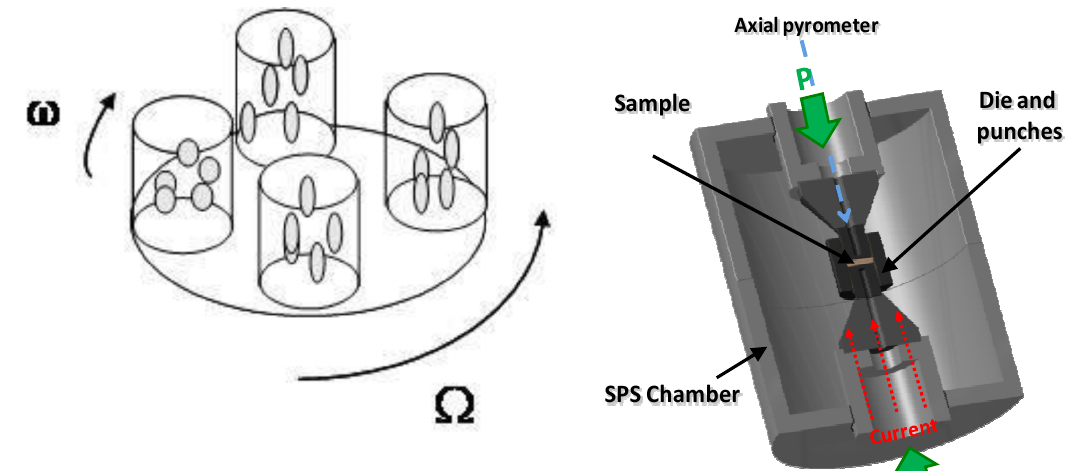
Fig. 1. Schematic illustration of the high-energy ball milling process.